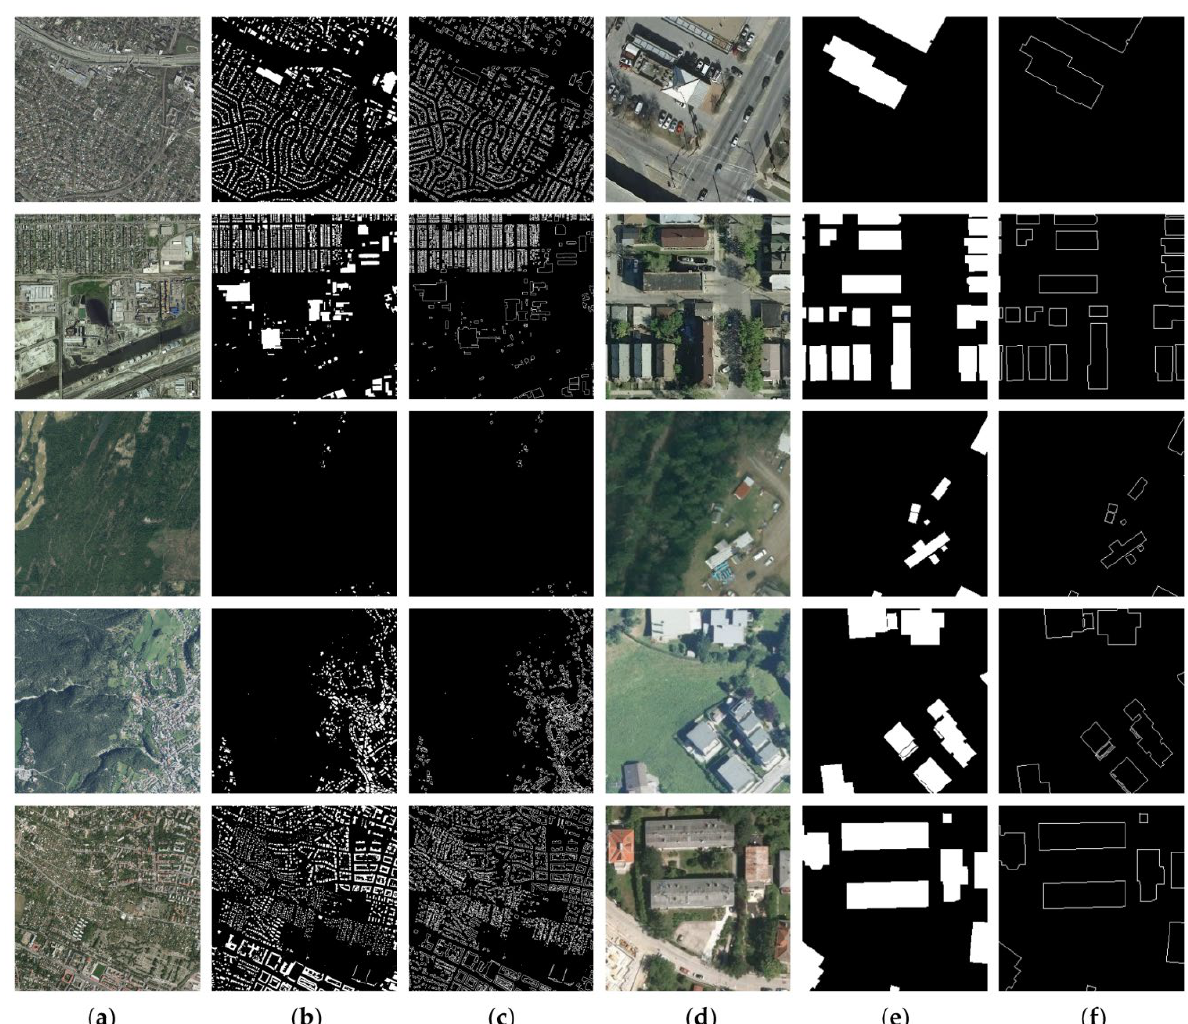
Figure 3. Samples of the Inria Building Dataset: ( a ) original image from Austin, Chicago, Kitsap, Tyrol and Vienna; ( b ) original reference building regions label; ( c ) building edges label; ( d – f ) enlarged patches in ( a – c ).